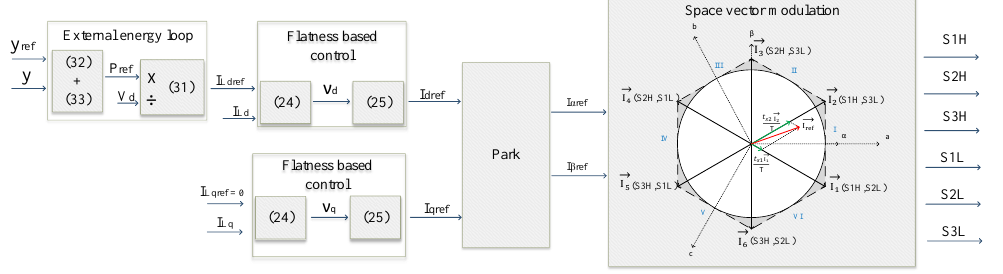
Figure 6. General control